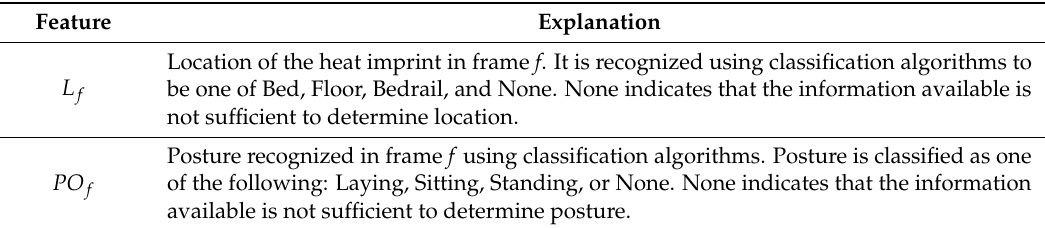
Table 2. Location and posture features.